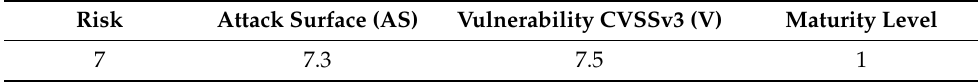
Table 19. IoT system mature levels.